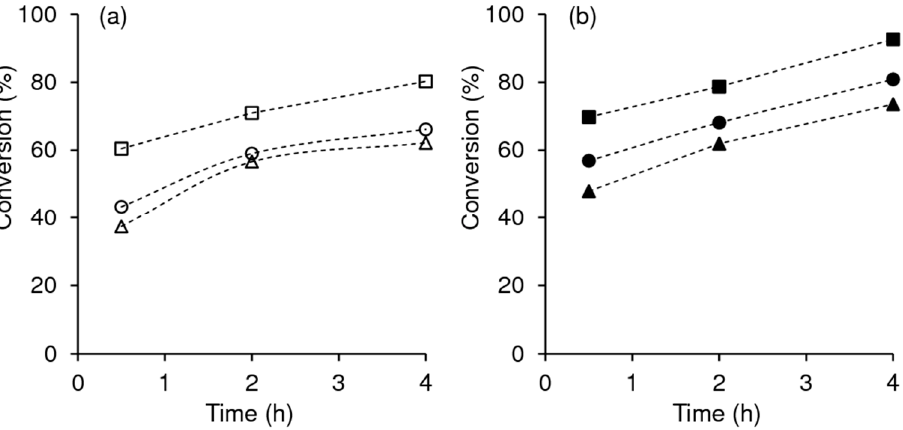
Figure 4. Kinetic profiles for the Fur/Gly reaction in the presence of 1 , at 50 °C (triangles), 70 °C (circles) or 90 °C (squares) using a catalyst load of ( a ) 3.8 g cat L − 1 or ( b ) 38 g cat L − 1 .